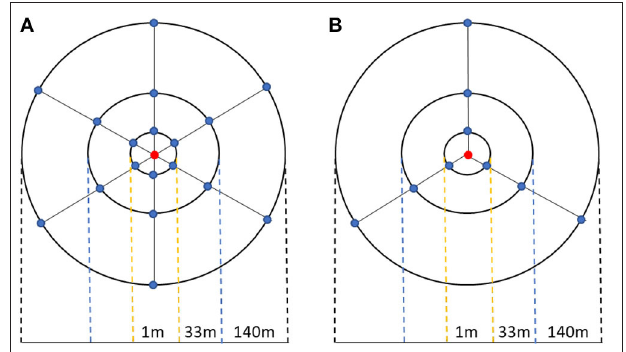
FIGURE 2 | Schematic representation of the soil-sampling campaigns. The red point represent the CRNP probe while the blue ones are the sampling soil locations. (A) the calibration procedure described by Heidbüchel et al. (2016) (T1 and T2 samples); (B) new calibration procedure used in this study (T3, C1, and C2